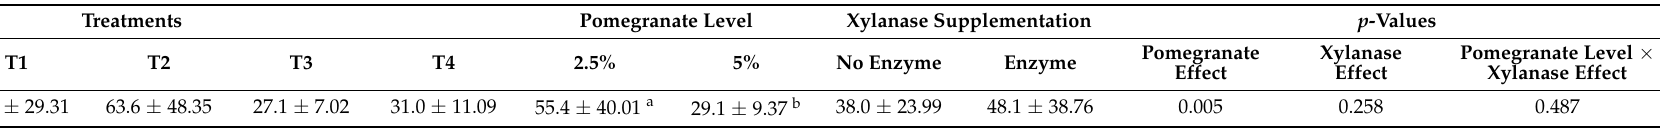
Table 4. Effects of two levels of pomegranate peel byproduct with or without xylanase on egg yolk Malondialdehyde (MDA) content egg. T1: 2.5% PPB; T2: 2.5% and xylanase; T3: 5% PPB; T4:5% PPB and